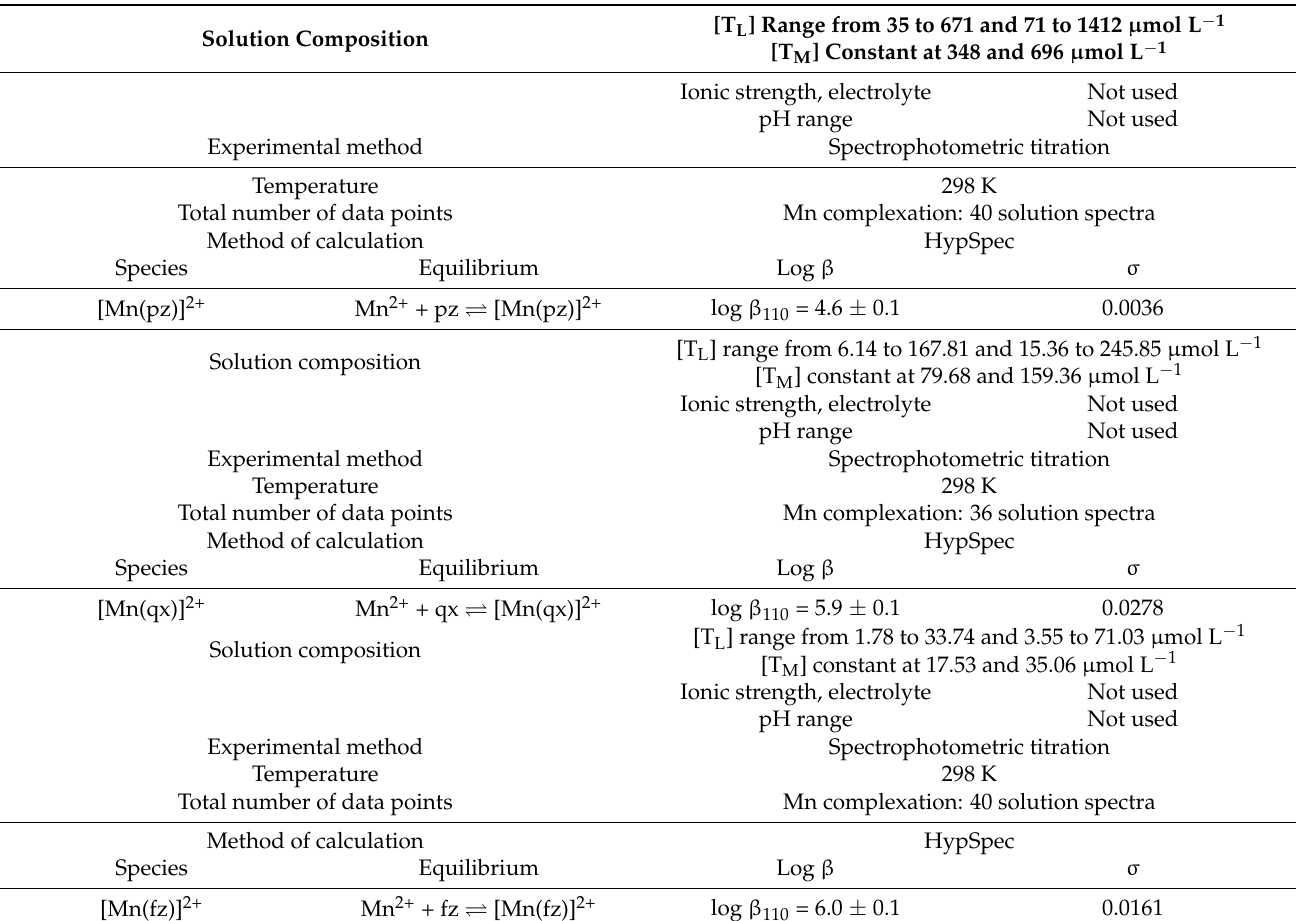
Table 1. Summary of experimental parameters for the systems Mn 2+ with pyrazine (pz), quinoxaline (qx) and phenazine (fz), in